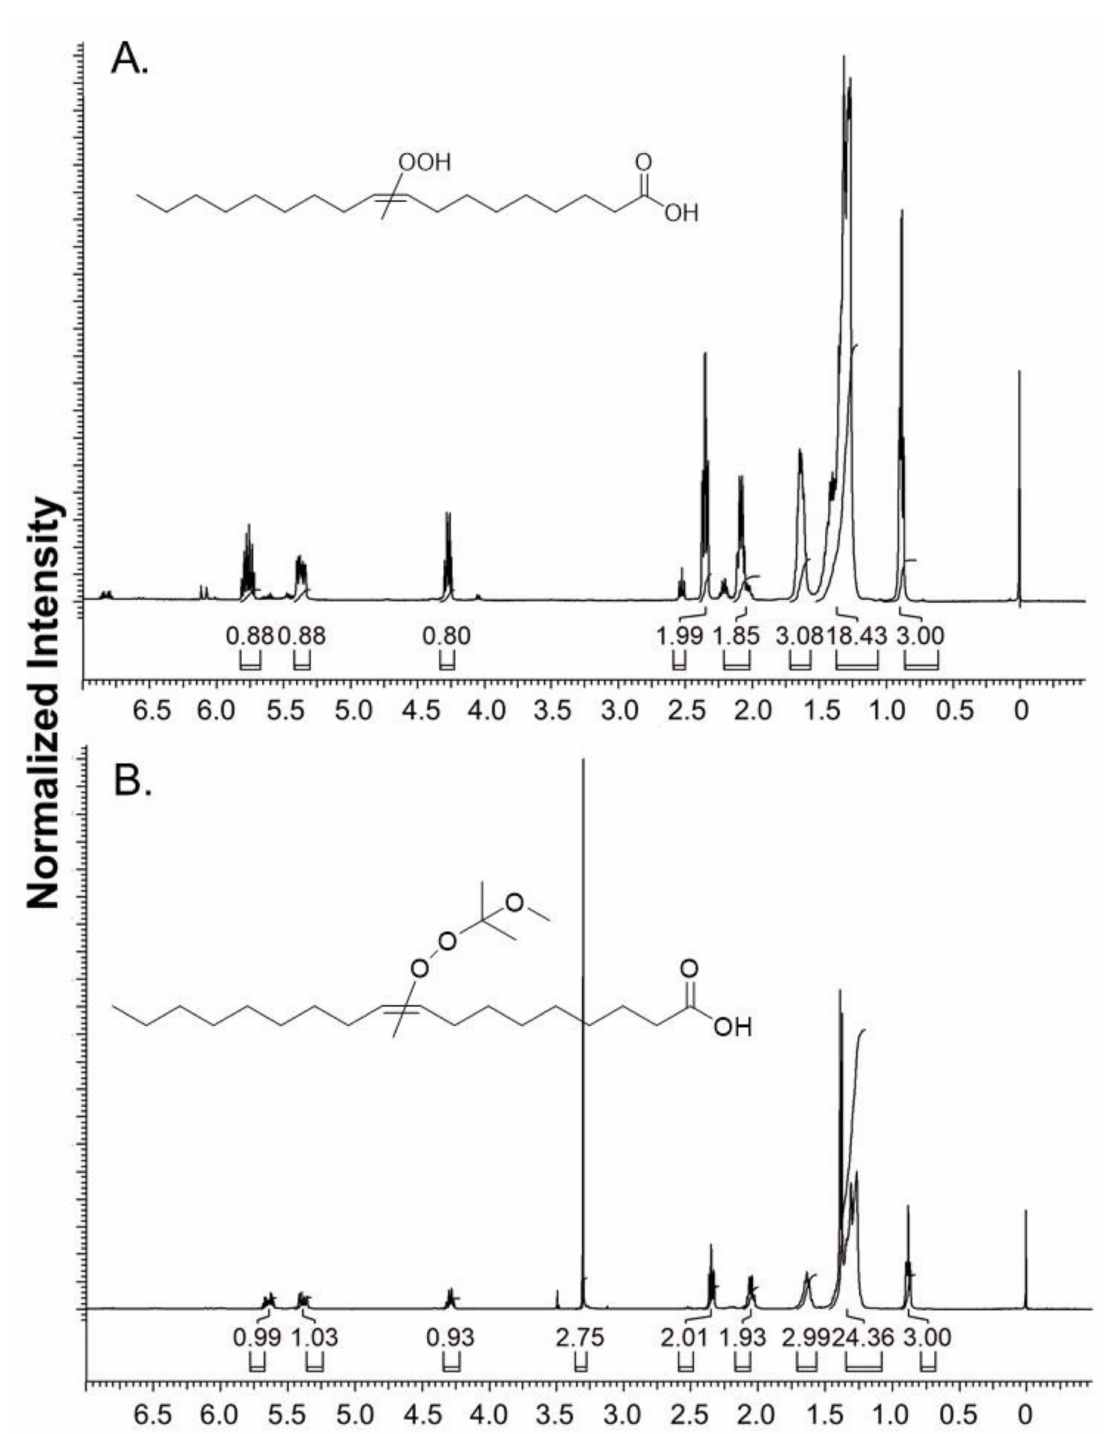
Figure 2. The 1H-NMR spectrum of FA 18:1-OOH ( A ) and its 2-MxP derivative FA 18:1-OOMxP ( B